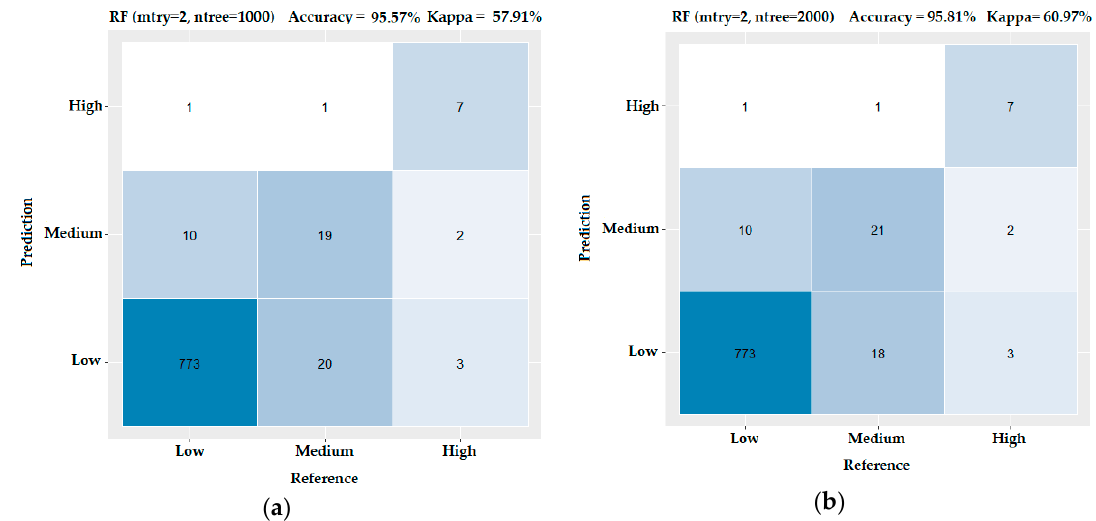
Figure 8. Confusion matrixes for the RF algorithm under di ff erent combinations of tuning parameters regarding the test subset. On the top of each matrix the performance indices—Accuracy and Kappa— are illustrated. ( a ) The RF results for mtry = 2 and ntree = 1000 and ( b ) RF results for mtry = 2 and ntree = 2000.